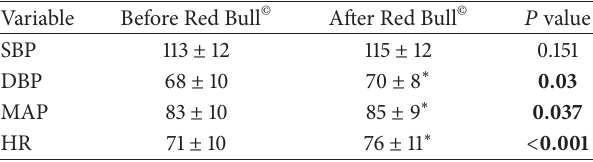
Table 1: Arterial blood pressure and heart rate of study population. Variable Before Red Bull © After Red Bull © 𝑃 value SBP 113 ± 12 115 ± 12 0.151 DBP 0.03 MAP 83 ± 10 85 ± 9 ∗ 0.037 HR 71 ± 10 76 ± 11 ∗ < 0.001